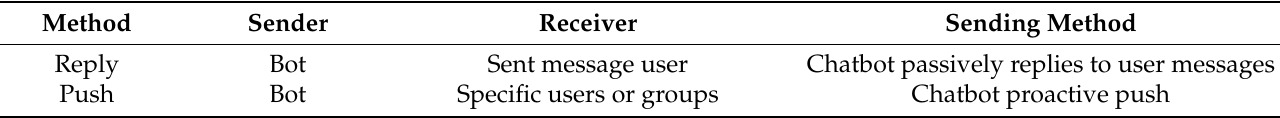
Table 3. Two ways to send messages on instant messaging platforms.